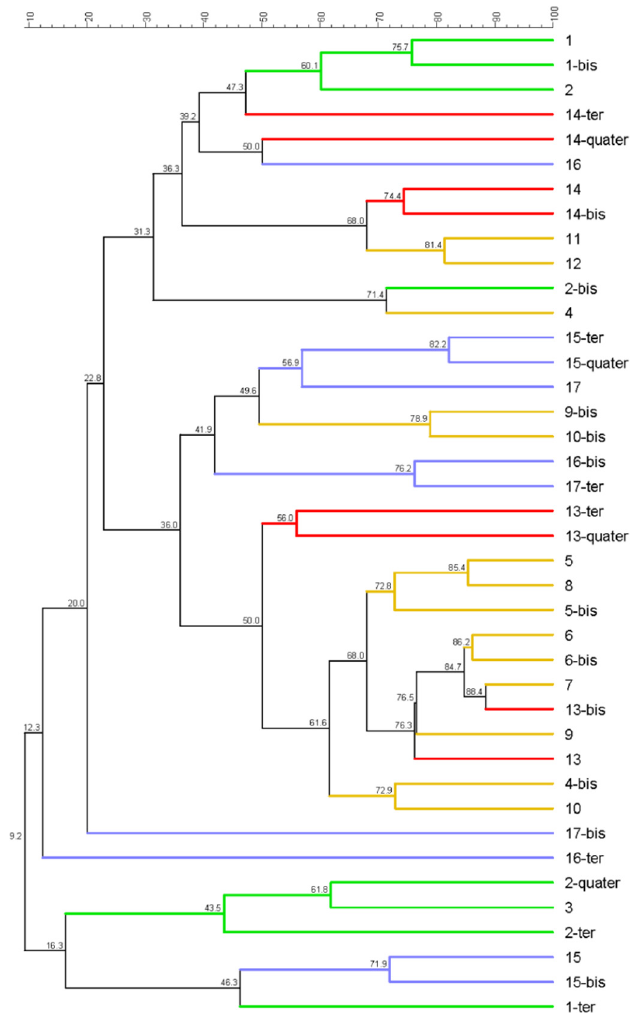
Figure 2. Phylogenetic analysis, bacteria dendrogram of samples. Pearson similarity coe ffi cients are reported near the node. Colour legend: green (organic fraction of municipal solid waste (OFMSW)), yellow (agricultural and livestock biomasses (ALB)), red (wastewater treatment sludge (WWTS)), and violet (lignocellulosic biomasses (LCB)). Replicate samples (i.e., 1-1bis-1ter-1quater) are also reported. Whenever -ter and -quarter replicates are present, those are from LMA samples.